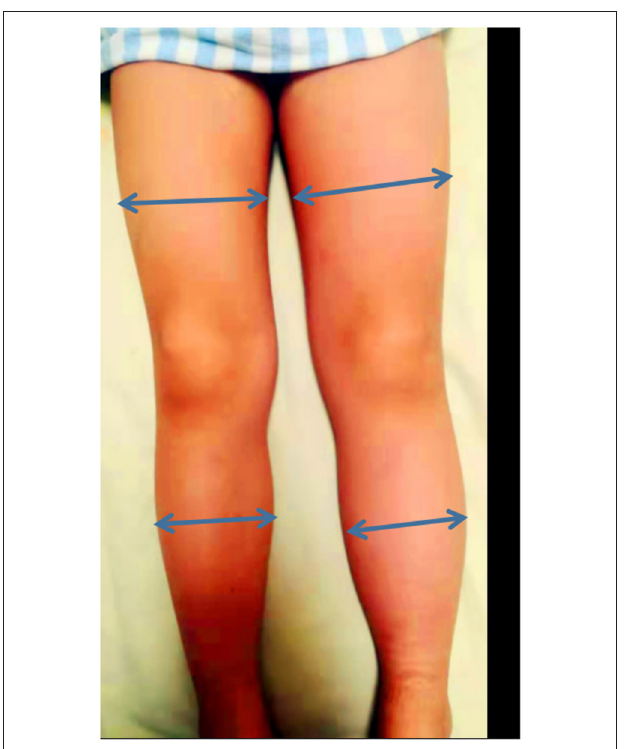
FIGURE 1 | The left lower extremity swelling.